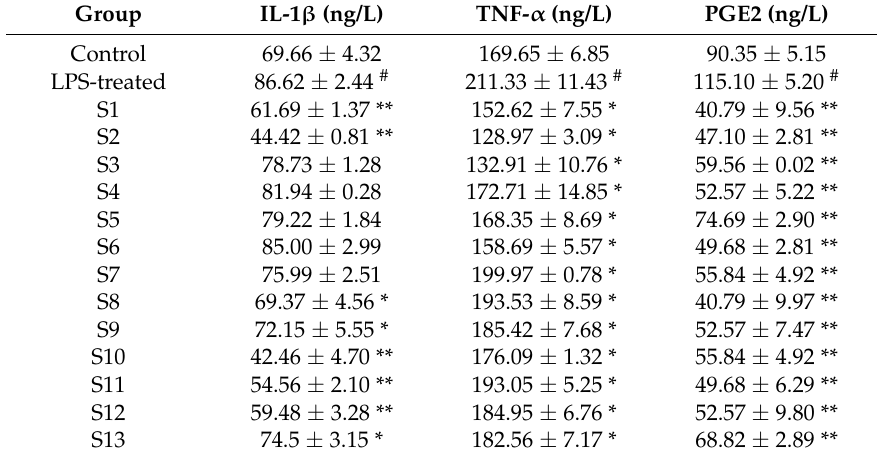
Table 7. Inhibitory effects of collagen peptides on lipopolysaccharide (LPS)-induced IL-1 β , TNF- α , and PGE2 release in C518